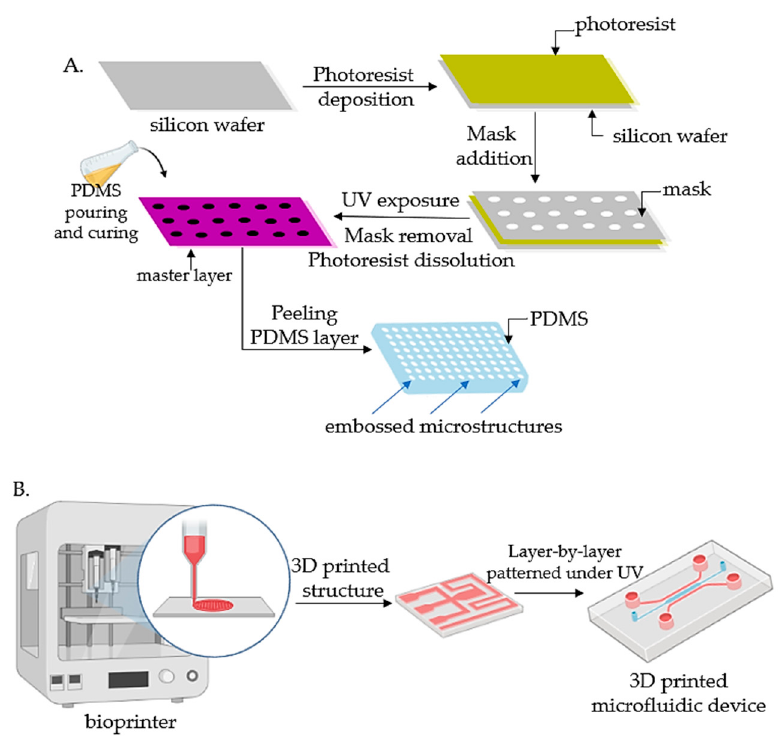
Figure 1. Fabrication technologies for OOCs: ( A ) The fabrication of micropatterned slabs of PDMS through photolithography; ( B ) Schematic 3D-printing process for the fabrication of microfluidic